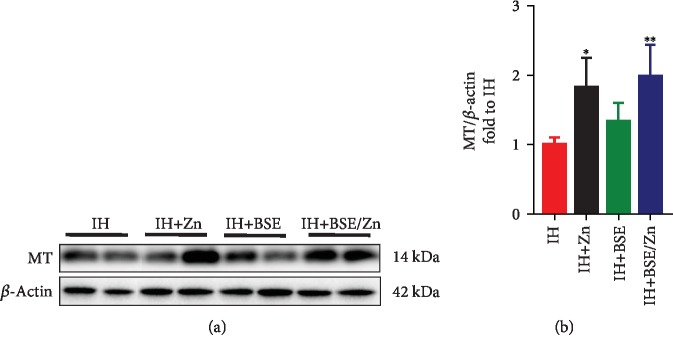
BSE and/or Zn treatment increases the protein expression of metallothionein (MT). Protein expression of MT measured by western blotting. Data are presented as the means ± SD (n = 4). ∗P < 0.05vs. IH group mice; ∗∗P < 0.01vs. IH group mice.